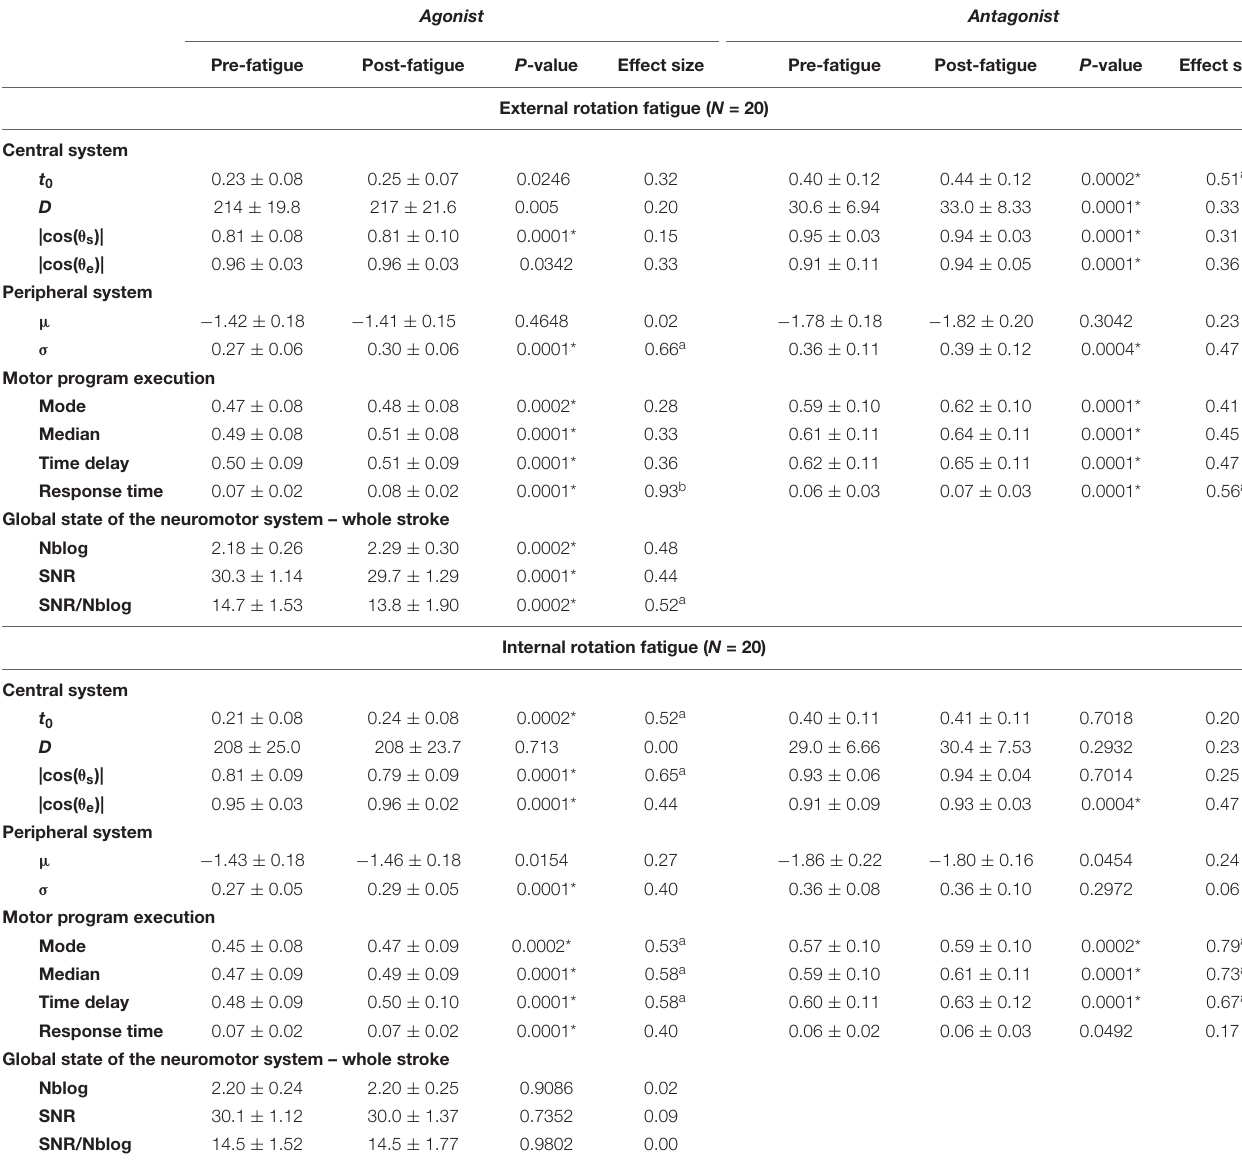
TABLE 2 | Parameters evolution in the simple strokes after a shoulder fatigue in external or internal